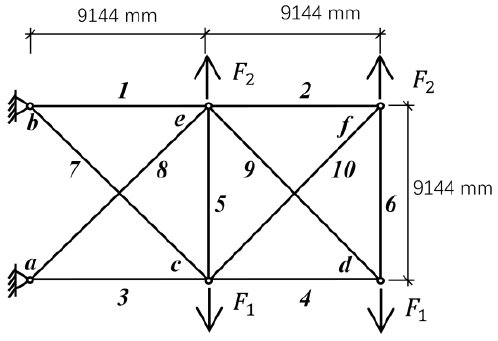
Figure 12. Design domain for experiment 3. In each load case, F 1 and F 2 represent the different load sizes of nodal load.